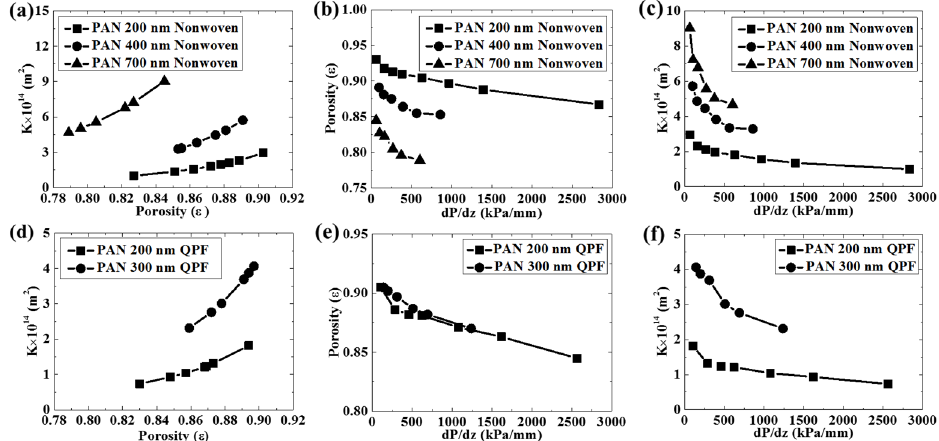
Figure 5. For nonwoven random fibrous membranes with various fiber diameters, the relationships between ( a ) permeability constant and porosity, ( b ) porosity and pressure drop, ( c ) permeability constant and hydraulic pressure drop. For QPF membranes with various fiber diameters, the relationships between ( d ) permeability constant and porosity, ( e ) porosity and pressure drop, ( f ) permeability constant and hydraulic pressure drop.